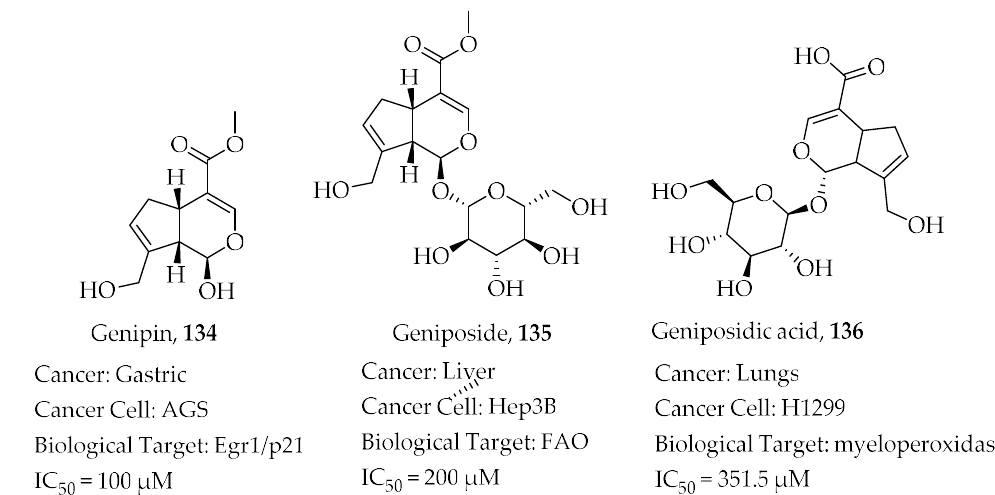
Figure 27. Structure of the iridoid glycosides Genipin, Geniposide and Geniposidic acid with a sum- mary of their biological activity towards selected cancer targets.